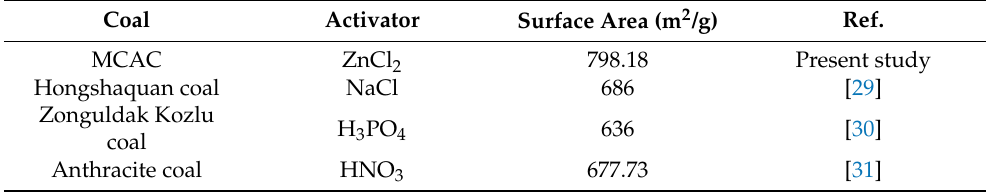
Table 4. Comparison of the surface area of coal from different